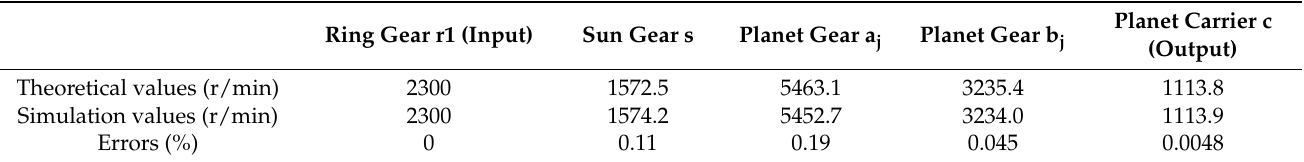
Table 2. Comparison between simulation value and theoretical values of rotational speed.